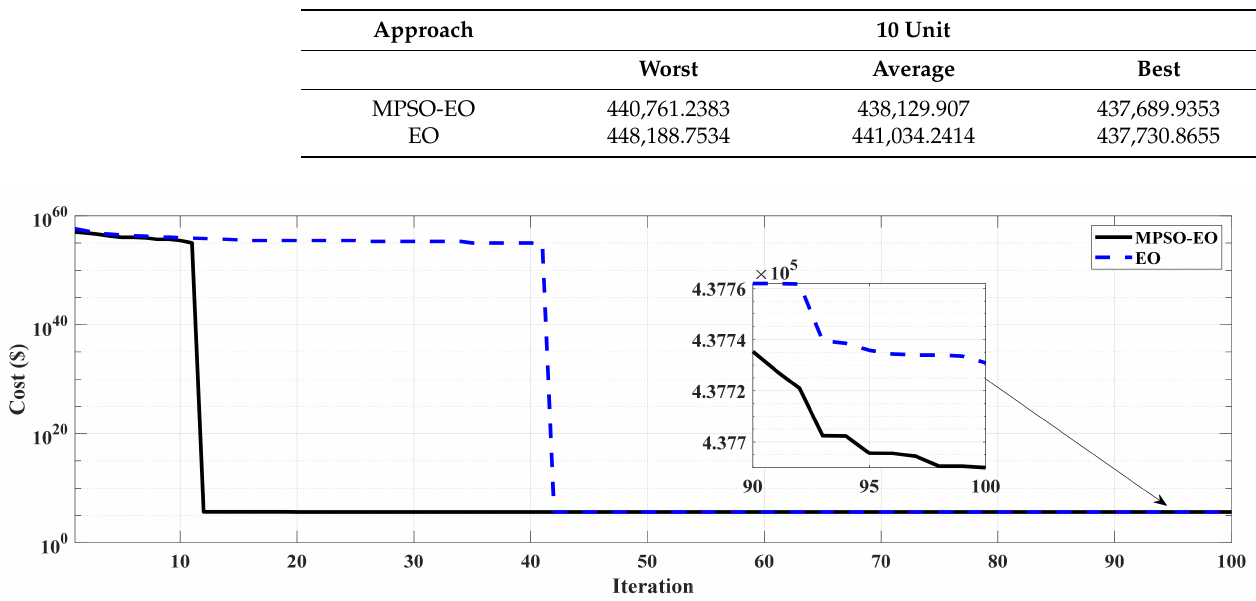
Table 14. Comparison between MPSO-EO and standard EO (test system 2).